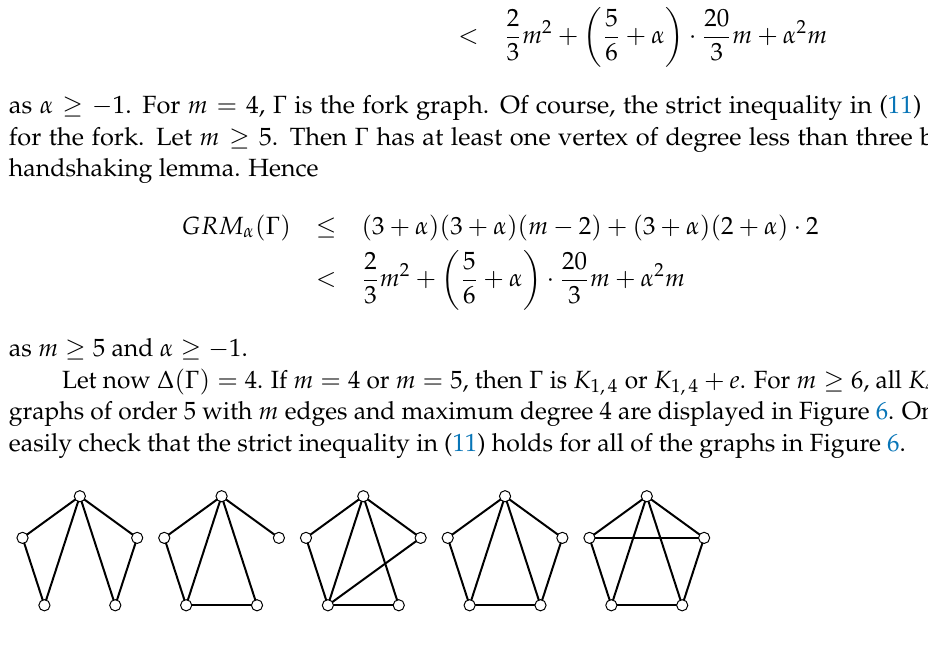
Figure 6. All K 4 - free graphs of order 5 with m ( m ≥ 6) edges and ∆ =